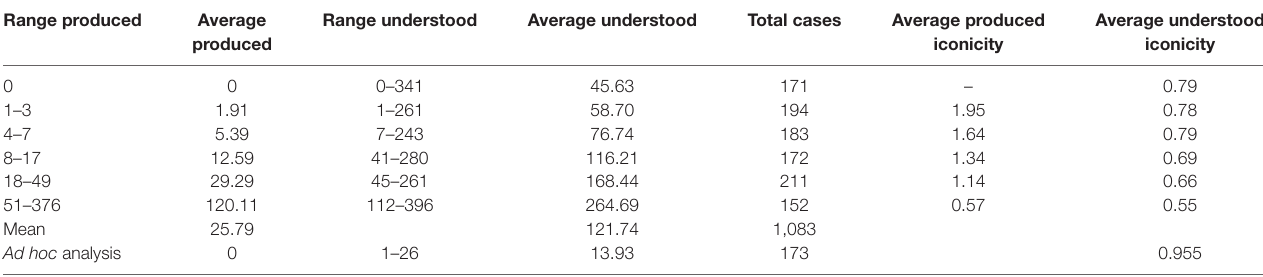
TaBle 6 | six partitions of the individual results of 1,089 children based on the number of words produced, giving the range and average of the number of words produced, the range and average number of words understood, the number of cases contributing to each partition of the analysis, and the average iconicity of the produced and understood